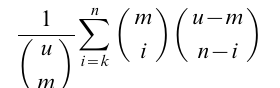
Table S1 a) Identification of peptides in the Swm complex